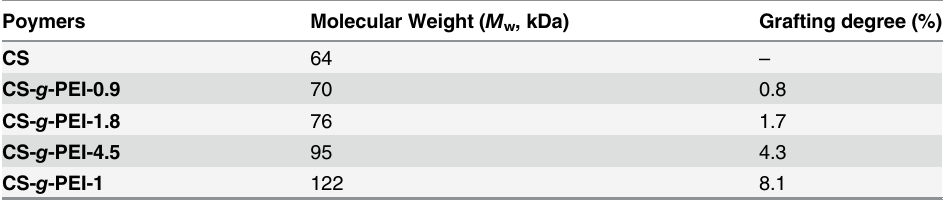
Table 1. Molecular weight ( M w ) of CS- g -PEI copolymers measured by GPC.